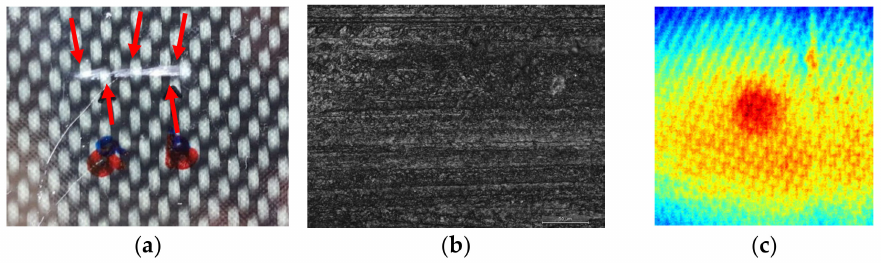
Figure 17. Images of the front face of panel 7: ( a ) microscopic image showing damage from the impact, ( b ) magnification showing matrix cracking, and ( c ) thermographic image showing internal damages. Panels 6 and 18 were impacted at 7.7 J with a sharp projectile and 7.3 J with a smooth projectile, respectively, with both at an angle of 28.5 ◦ . Both panels presented scratches in the area of the impact. However, panel 6 did not present damage on its back face, while panel 18 had a matrix crack (Figure